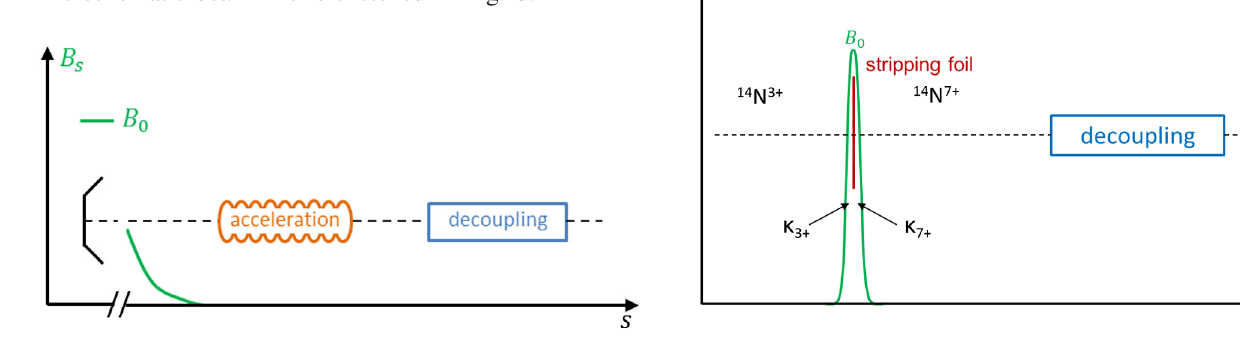
FIG. 7. Schematic beam line of EMTEX at GSI for transverse emittance transfer